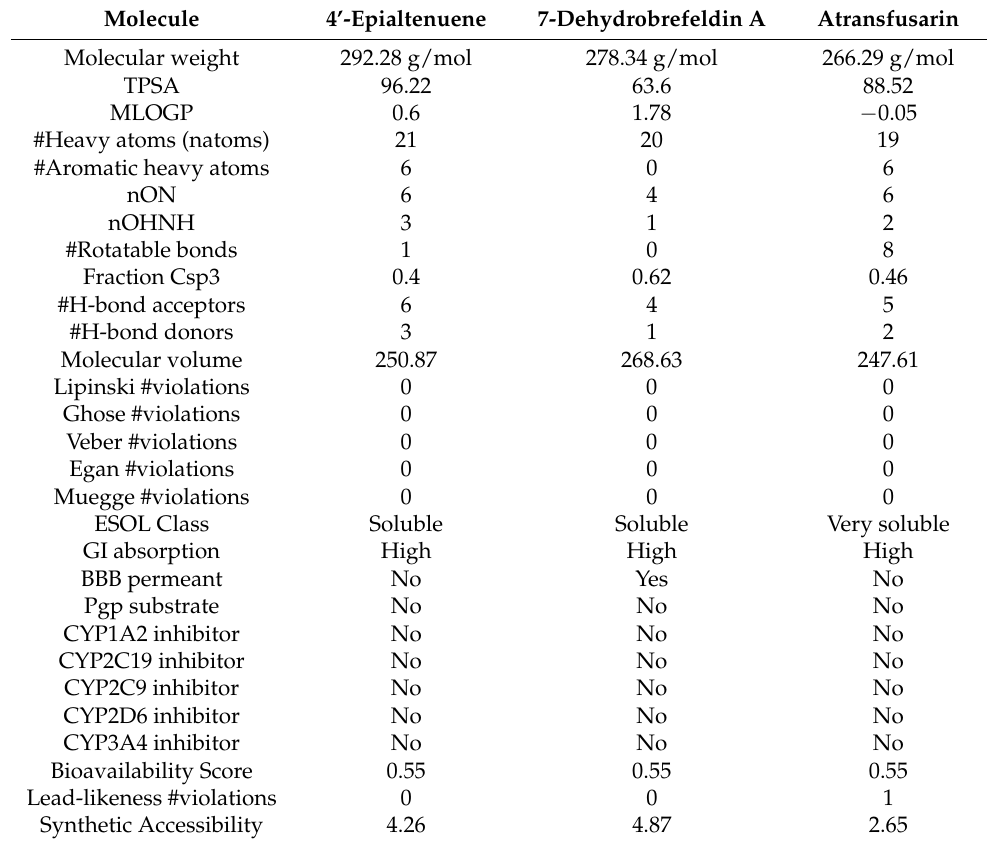
Table 6. Detailed in silico assessment of molecular properties, drug-likeness, absorption, distribution, metabolism, and excretion of 4’-epialtenuene, 7-dehydrobrefeldin A, and atransfusarin.